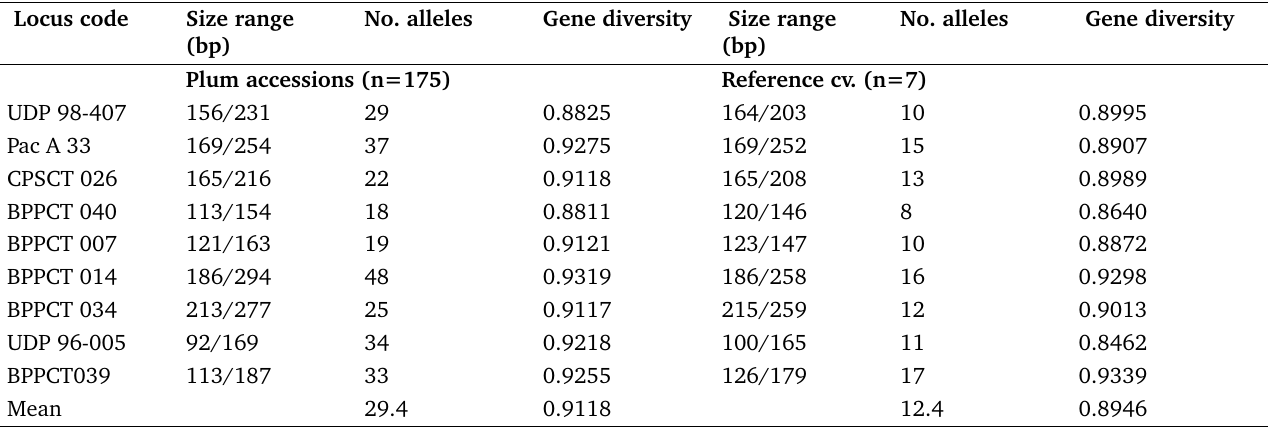
Table 2. Allele size range, number of alleles and gene diversity (Nei, 1978) for 9 SSR loci, calculated among 175 plum accessions investigated by Gaˇsi et al (2020) and by Sehic et al (2015), as well as among 7 reference cultivars. Locus